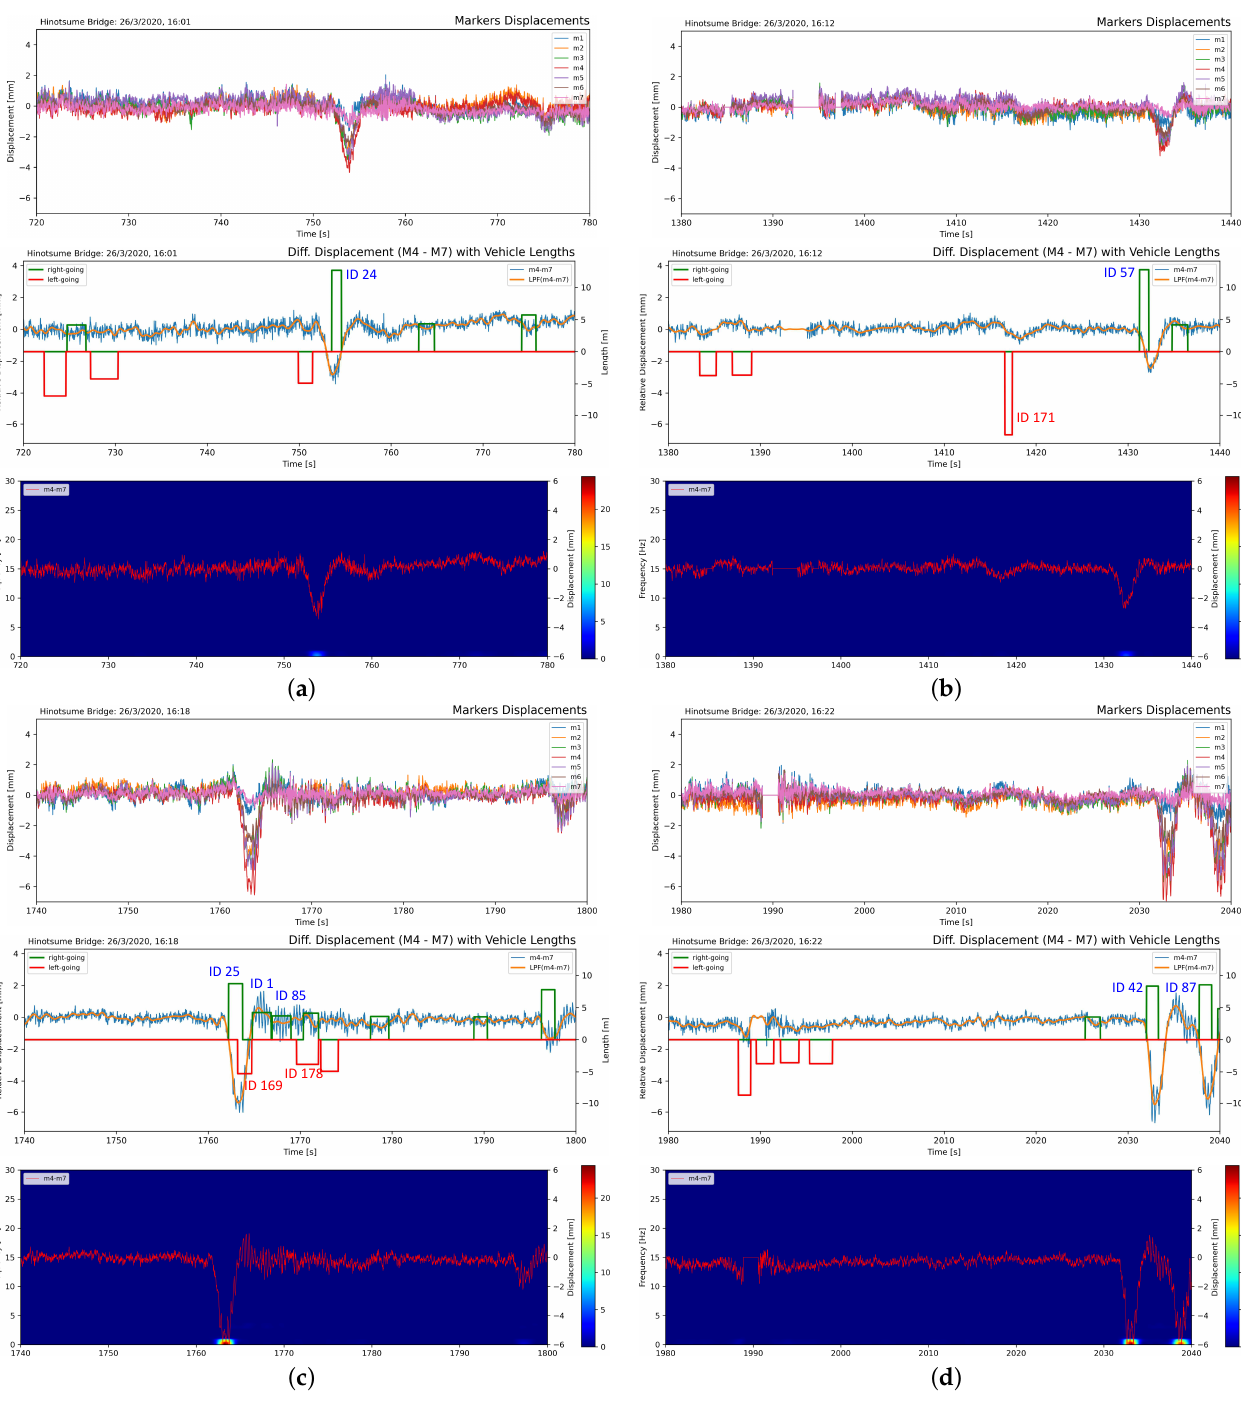
Figure 14. One minute segment of raw marker displacement, differential displacement between M4 and M7, and vibration frequency response at 16:01 ( a ), 16:12 ( b ), 16:18 ( c ), and 16:22 ( d ). The identified passing vehicles in the passes are mentioned in Table 3. Low-frequency vibration spectrum was observed during the passes of large, right-going vehicles while the passes of small vehicles did not result in notable vibration as in the earlier part of ( a , b